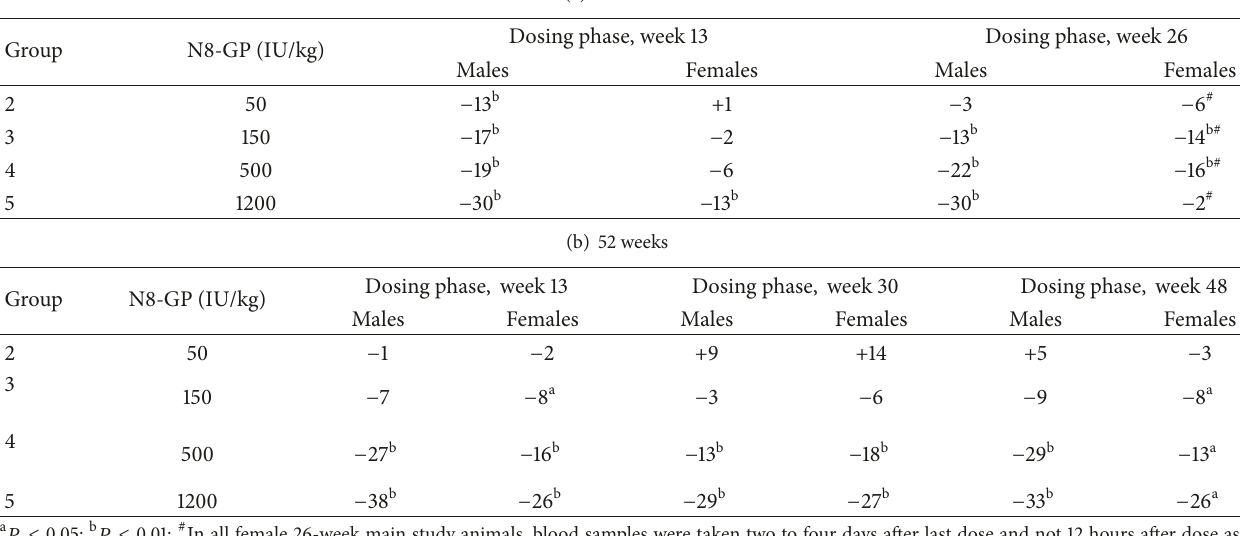
Table 5: Mean activated partial thromboplastin time—percentage deviation from controls (antibody-positive animals excluded) in the 26- and 52-week studies (the mean activated partial thromboplastin time in control animals across studies is ∼ 16 seconds).